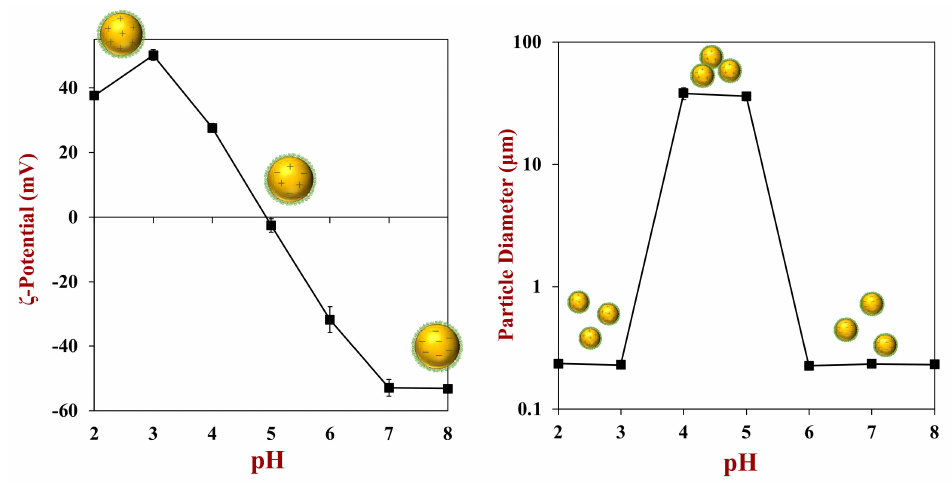
Figure 9. The electrical charge on protein-coated oil droplets goes from positive at low pH to negative at high pH because of changes in the ionization of the amino acid charge groups. Droplet aggregation tends to occur under conditions where there is not a strong electrostatic repulsion between the droplets, i.e., around the isoelectric point. Data is experimental measurements on whey protein- coated oil droplets prepared in our